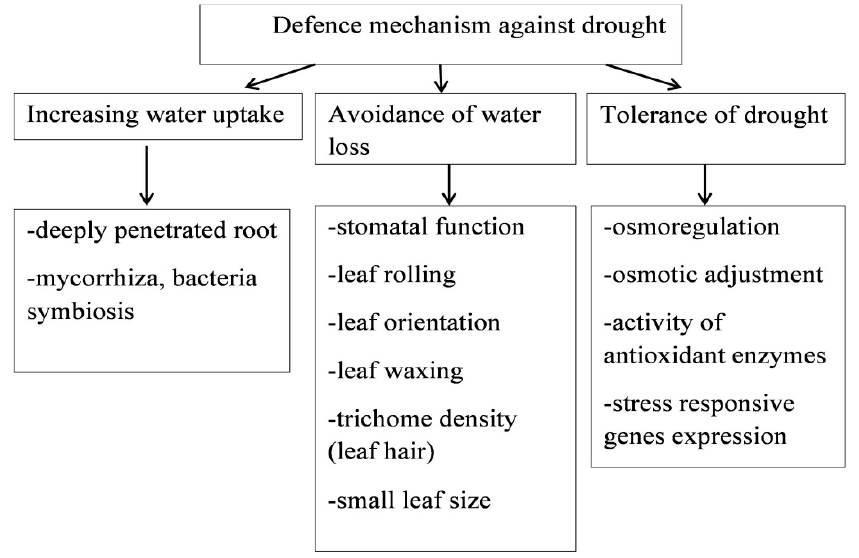
Figure 1. Defence mechanism against drought (Leonardis et al. [46]).